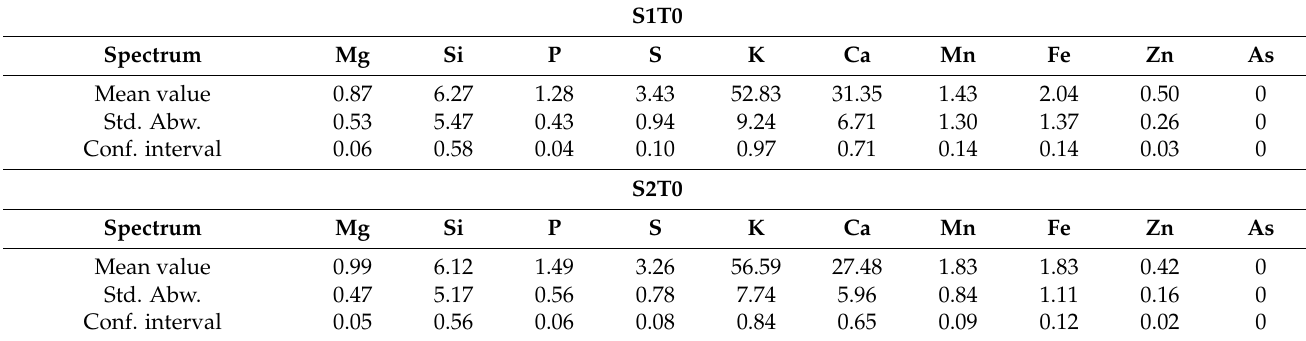
Table 1. µ -XRF semi-quantitative measurements of powder samples obtained from dried fronds of P. vittata grown on S1 or S2 soils at 0, 75 and 90 days. Results are expressed in Normalised Weight (wt%).